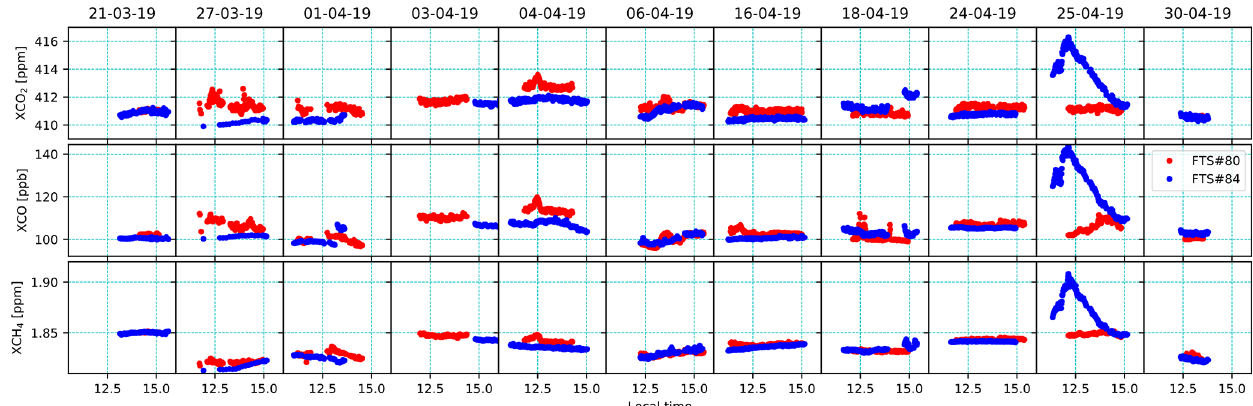
Figure 3. General overview of the full campaign results collected with the COCCON spectrometers (Makarova et al., 2021).